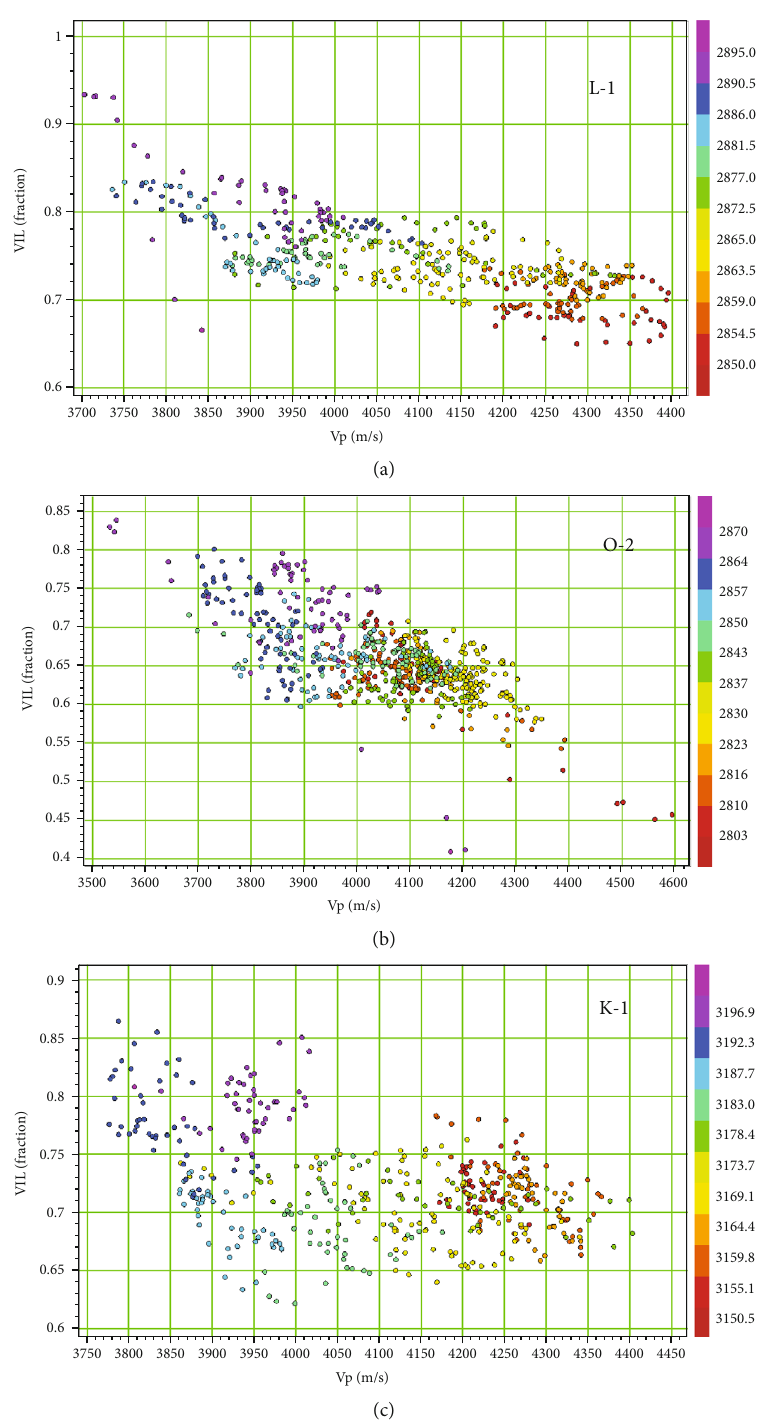
Figure 15: Cross plots showing relation for the Pas łę k Formation between volumetric clay mineral content (VIL) and P wave velocity. Depth is included as a colour scale. The data interval comes from wells L-1, O-2, and